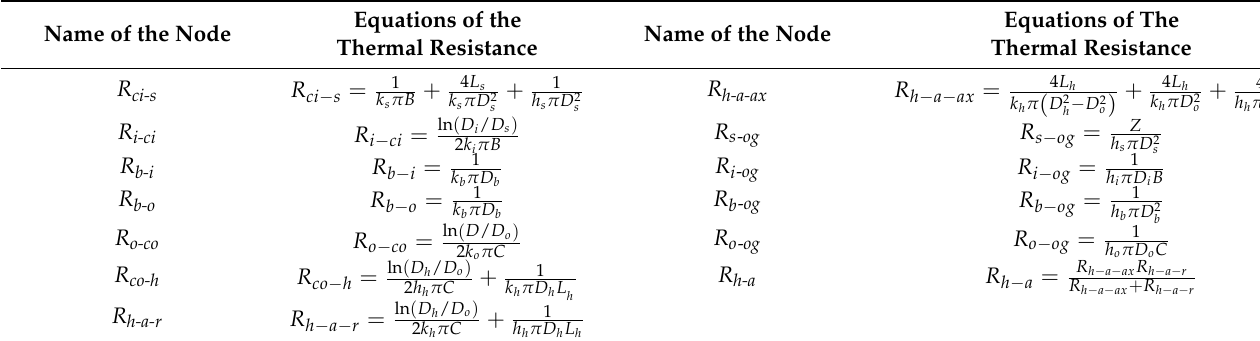
Table 2. Thermal resistance description table.